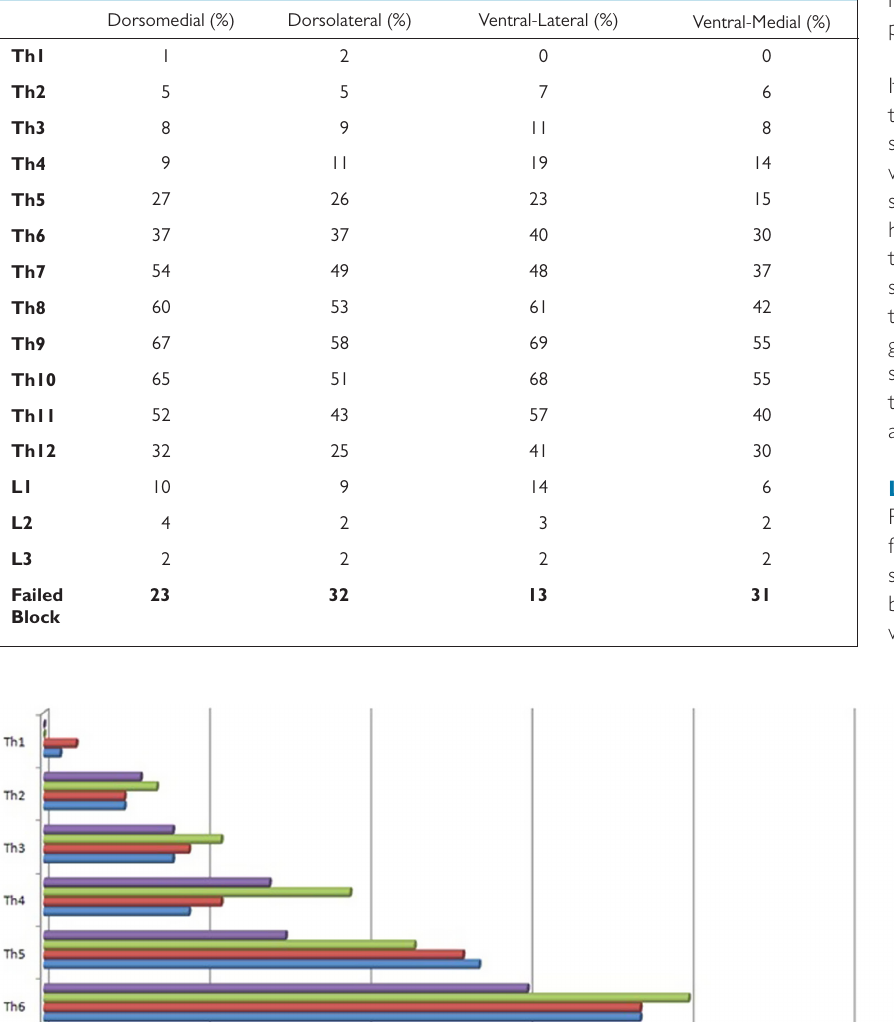
Table 2. Sensorial Block Involvement of Dermatomes